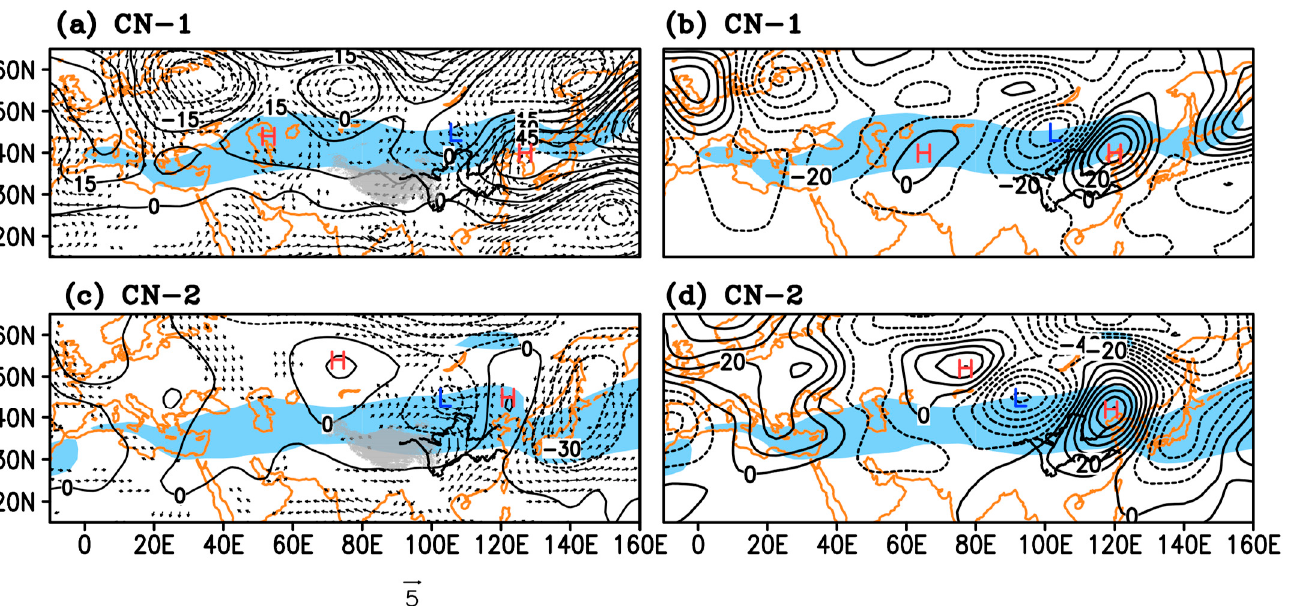
Figure 8. Composites of 500 hPa geopotential height anomalies (contour, units: gpm) and 850 hPa wind velocity (vector, unit: m·s − 1 ) ( a , c ) and of 300 hPa geopotential height anomalies ( b , d ) at Lag 0 days of the normal precipitation events in CN-1 ( a , b ) and CN-2 ( c , d ); the blue shaded regions indicate the zonal wind velocity (larger than 15 m/s) at 300 hPa, ‘Hb’ indicates the blocking high, and ‘H’ and ‘L’ indicate the high- and low-pressure anomalies, respectively. The clusters are based on all Lag 0 days of the normal precipitation events. The gray shaded areas in ( a , c ) indicate elevations > 3200 m.